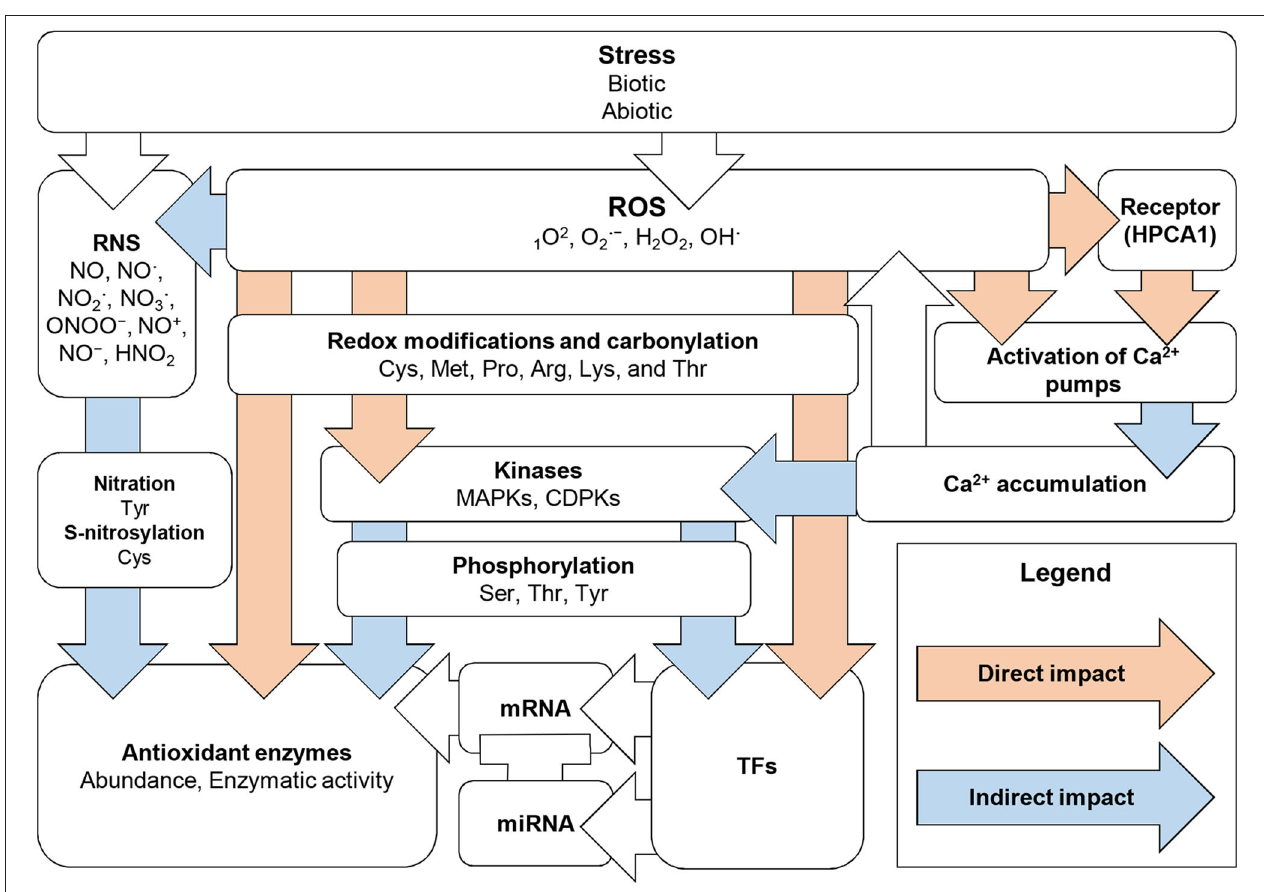
FIGURE 6 | Overview of direct and indirect mechanisms of antioxidant enzyme regulation in response to stress-induced ROS